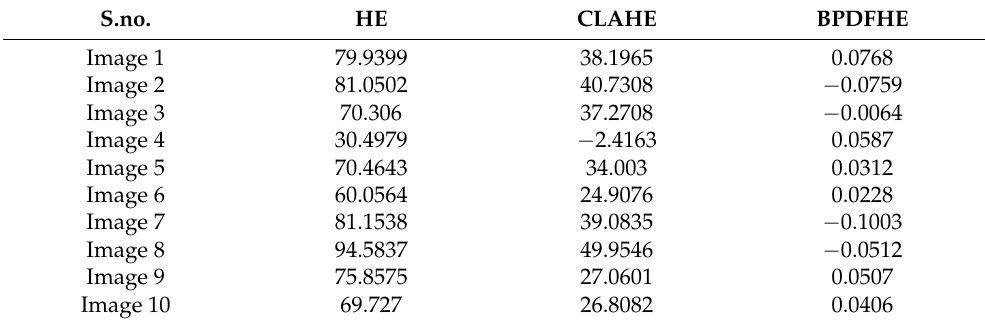
Table 4. Comparison of AMBE values.